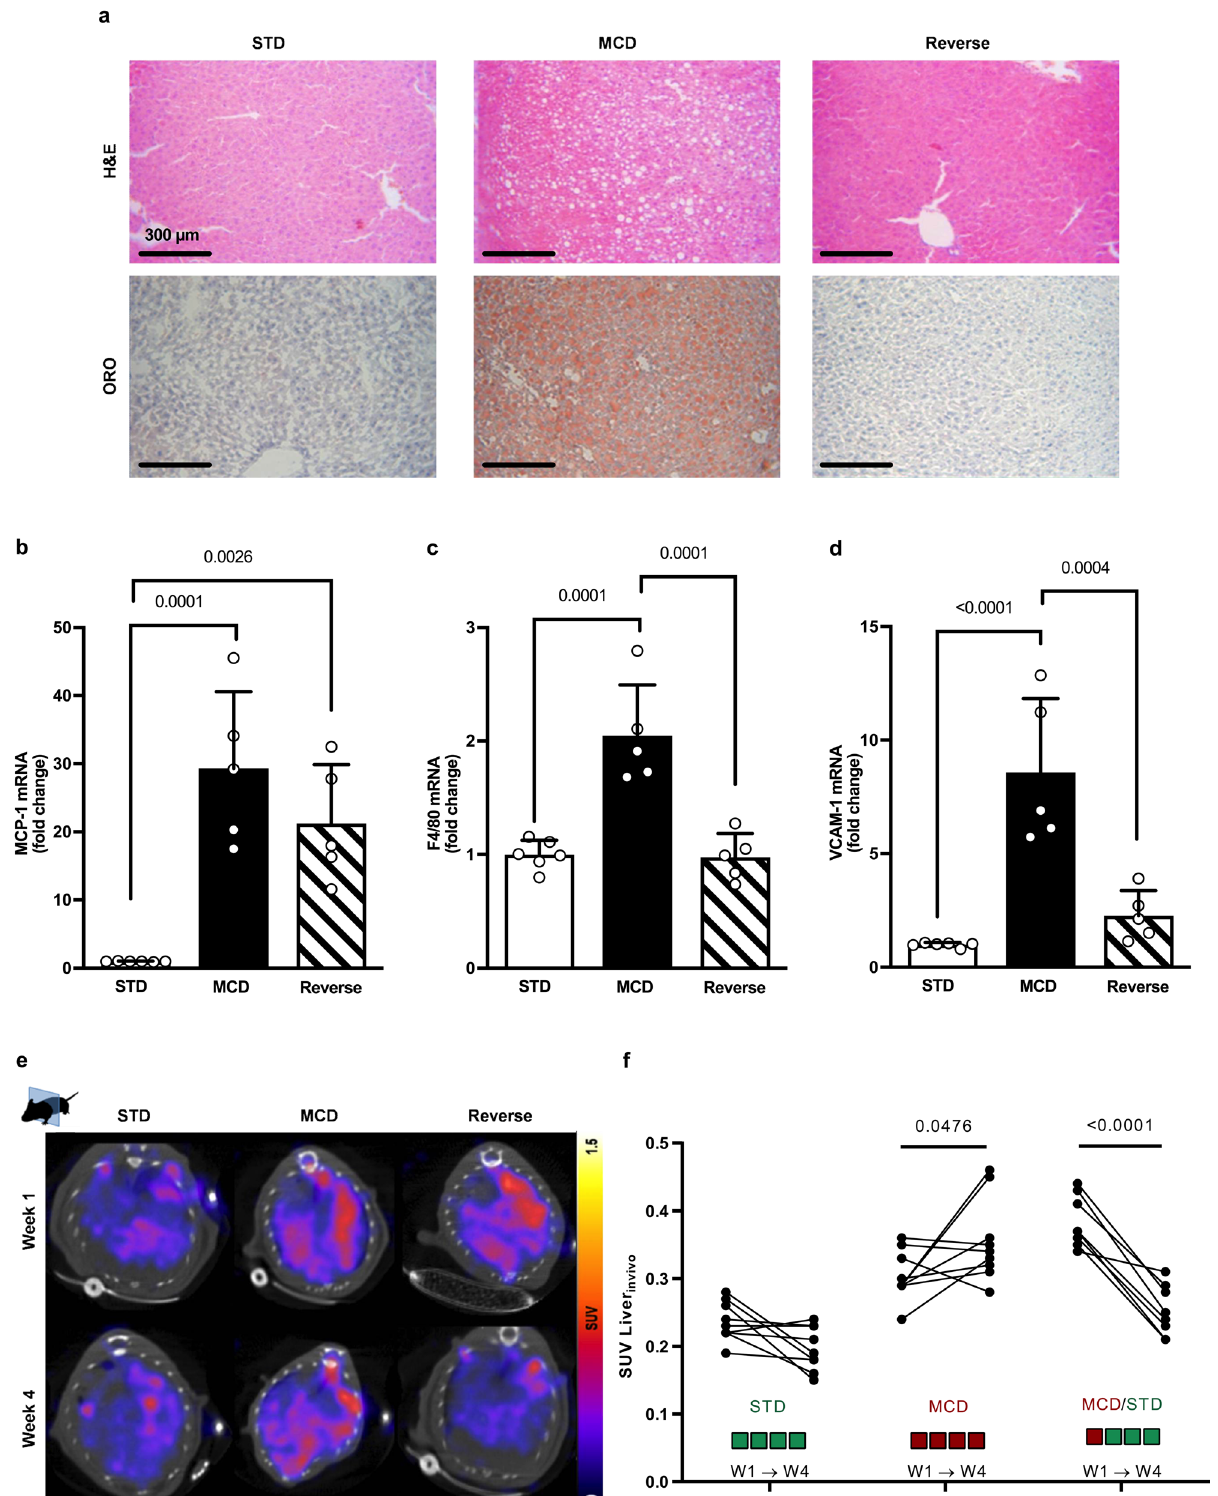
Fig. 2 | Liver uptake of 99m Tc-cAbVCAM1-5 upon steatohepatitis reversal. a Representative Hematoxylin & Eosin (H&E) and Oil red-O (ORO) liver staining (x200) in all groups. Liver mRNA expression of b MCP-1, c F4/80, and d VCAM-1 in the three groups of mice (one-way ANOVA, n =6 for V-STD and n =5 for V-MCD & V-Reverse groups, corrected for multiple comparisons using Tukey ’ s post hoc).